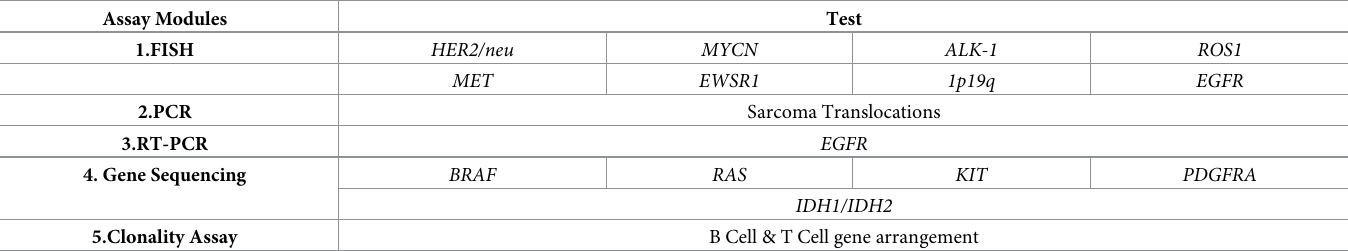
Table 1. Test schemes covered under MPQAP EQAS program for solid tumors. Assay